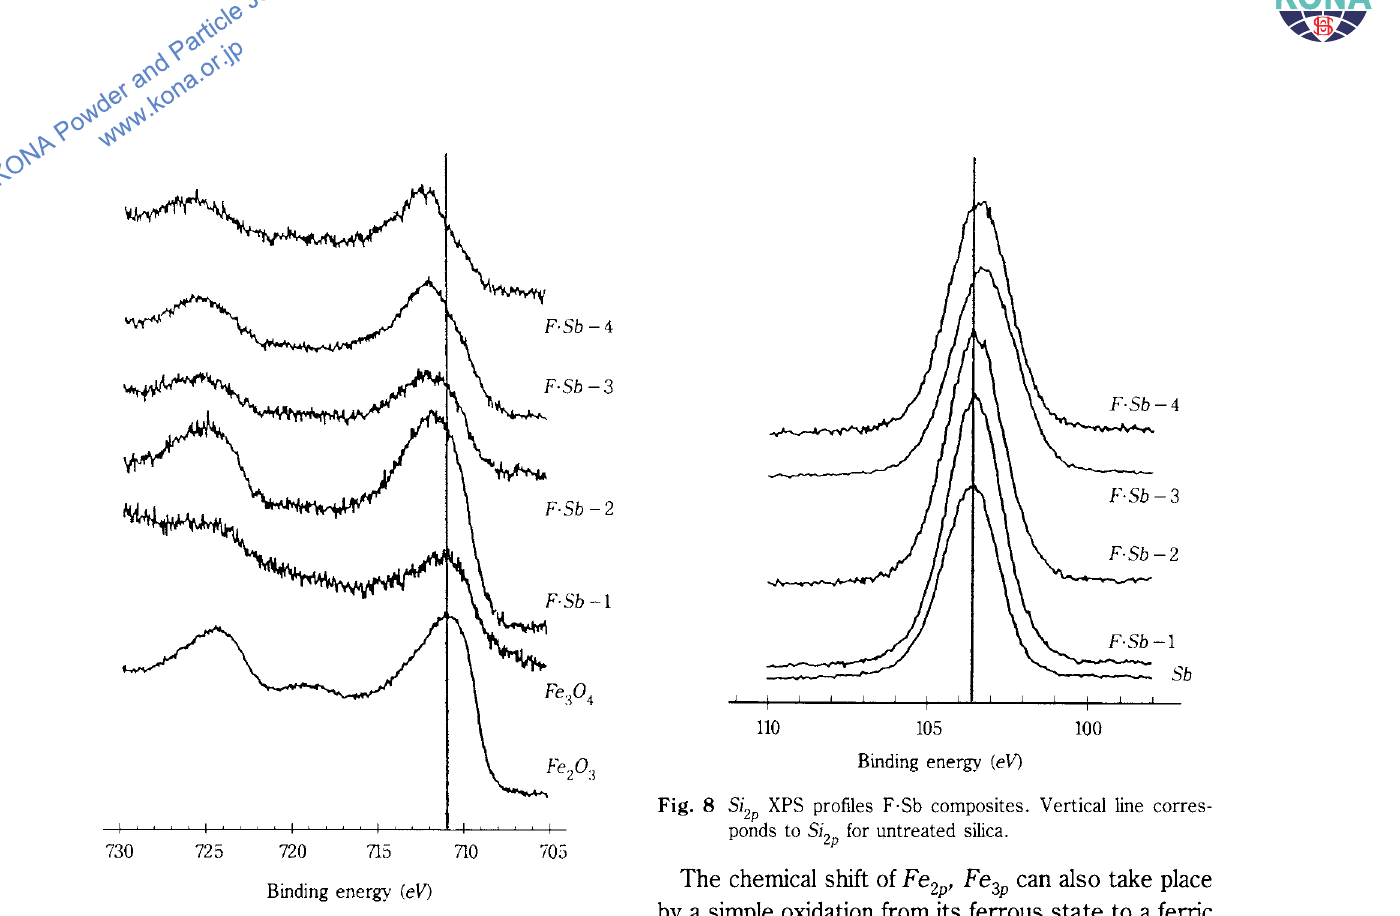
Fig. 8 Si 2P XPS profiles F·Sb composites. Vertical line corres ponds to Si 2P for untreated